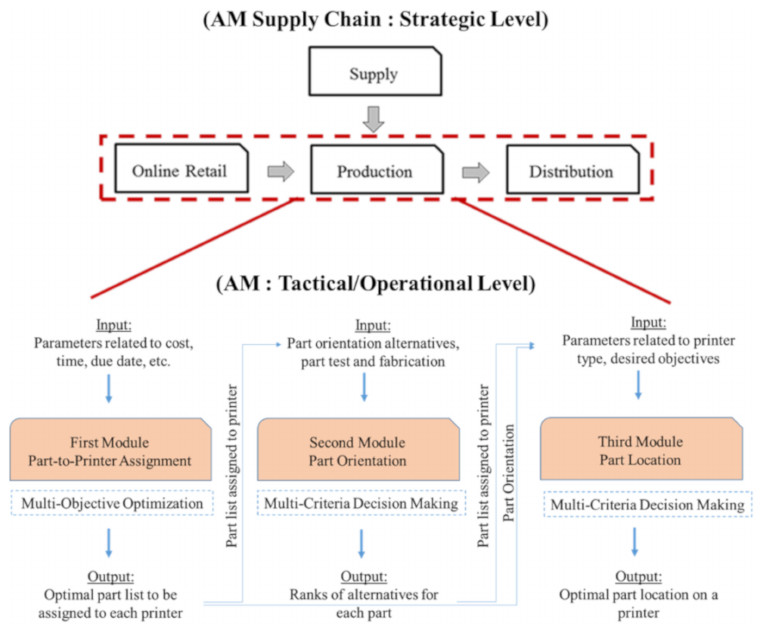
Figure 2. Production and distribution levels in an AM supply